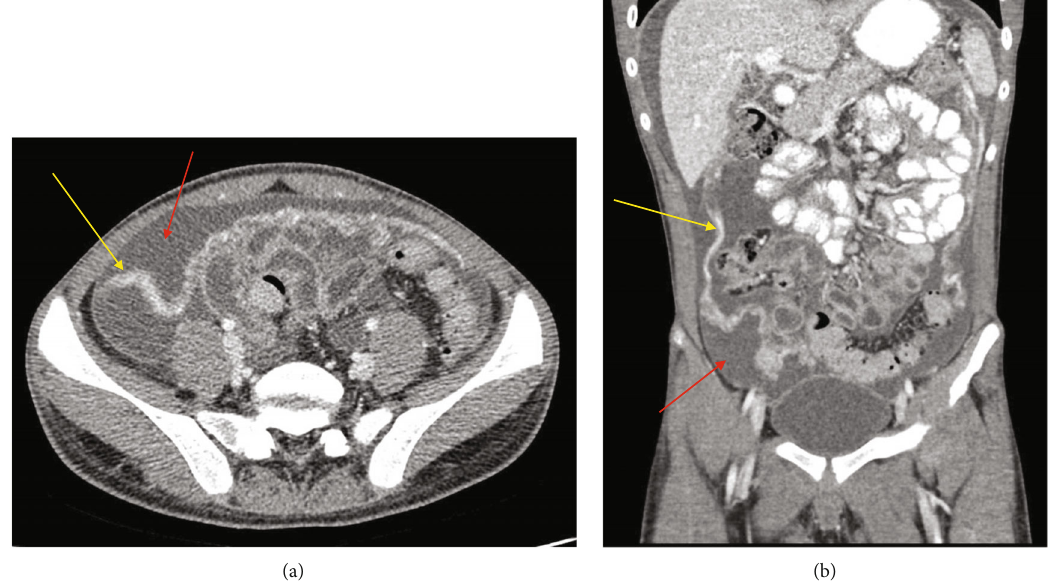
Figure 5: Contrast-enhanced axial (a) and coronal (b) CT images demonstrating omental thickening (yellow arrows) and ascites (red arrows).